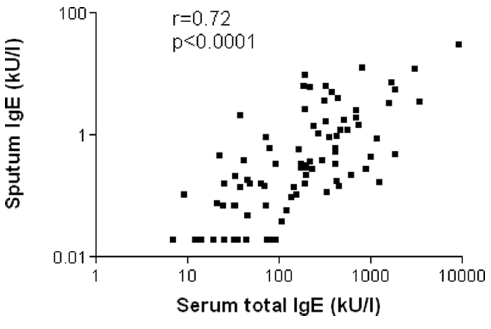
Figure 2. Correlation between sputum total IgE and serum total IgE in